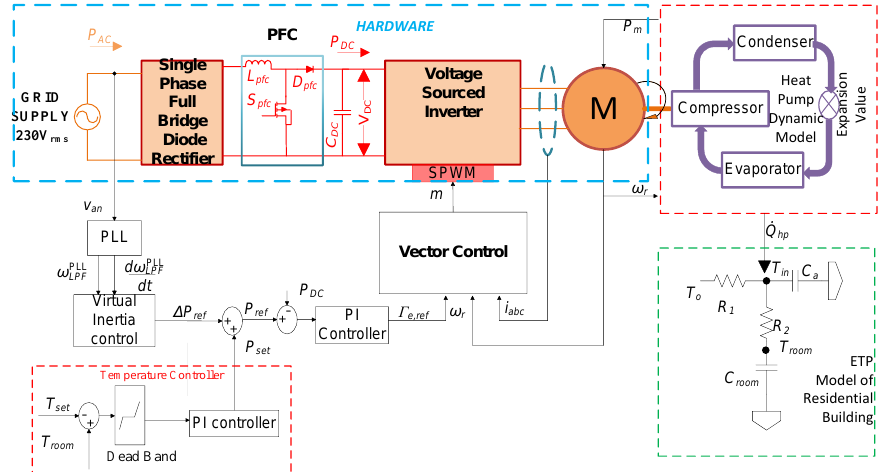
Figure 1. A simplified schematic diagram of the VSHP model with VSMcontrol and indoor air temperature control. PFC, power factor correction; ETP, equivalent thermal parameter.